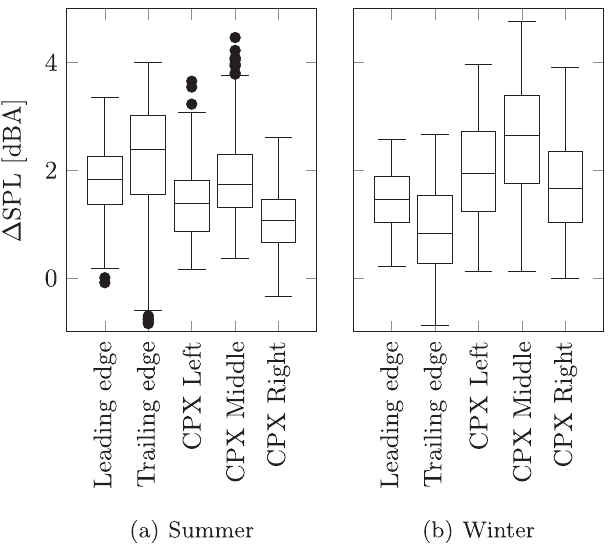
Figure 4. Averaged contribution of the groove resonance to the tire-road noise on all four road surfaces. The average is computed with all measurements (speeds between 30 and 120 km/h, loads between 2400 and 3600 N).